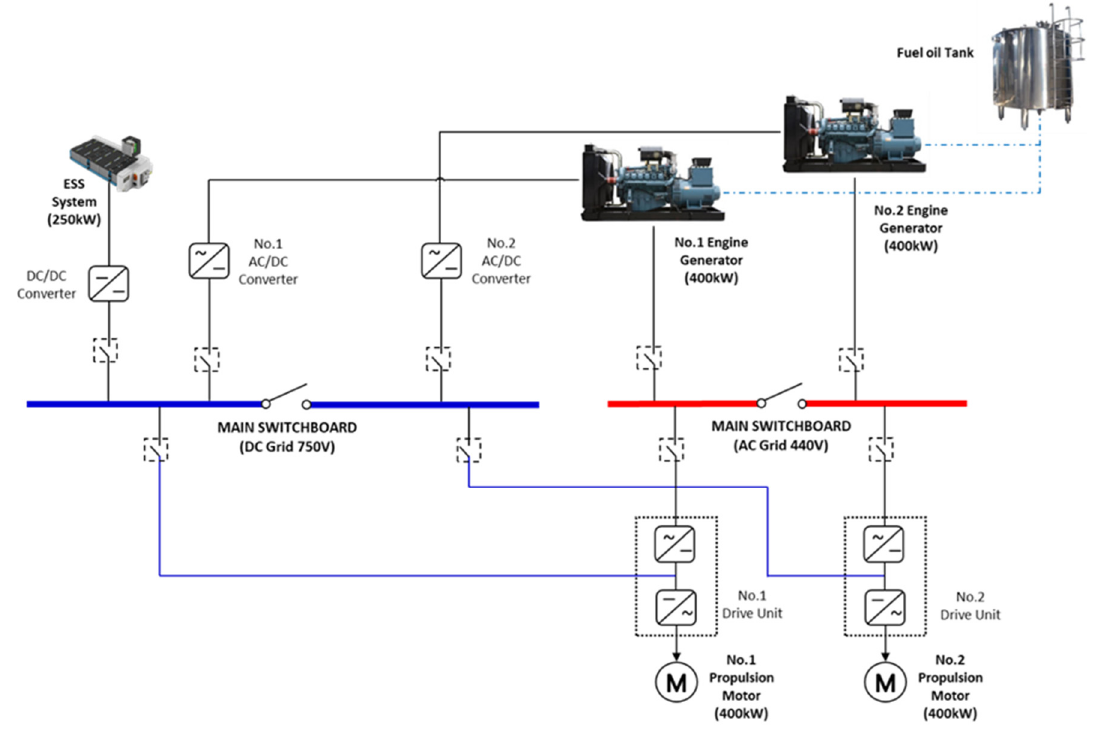
Figure 3. Schematic diagram of the DC grid system designed for the MASTC laboratory.